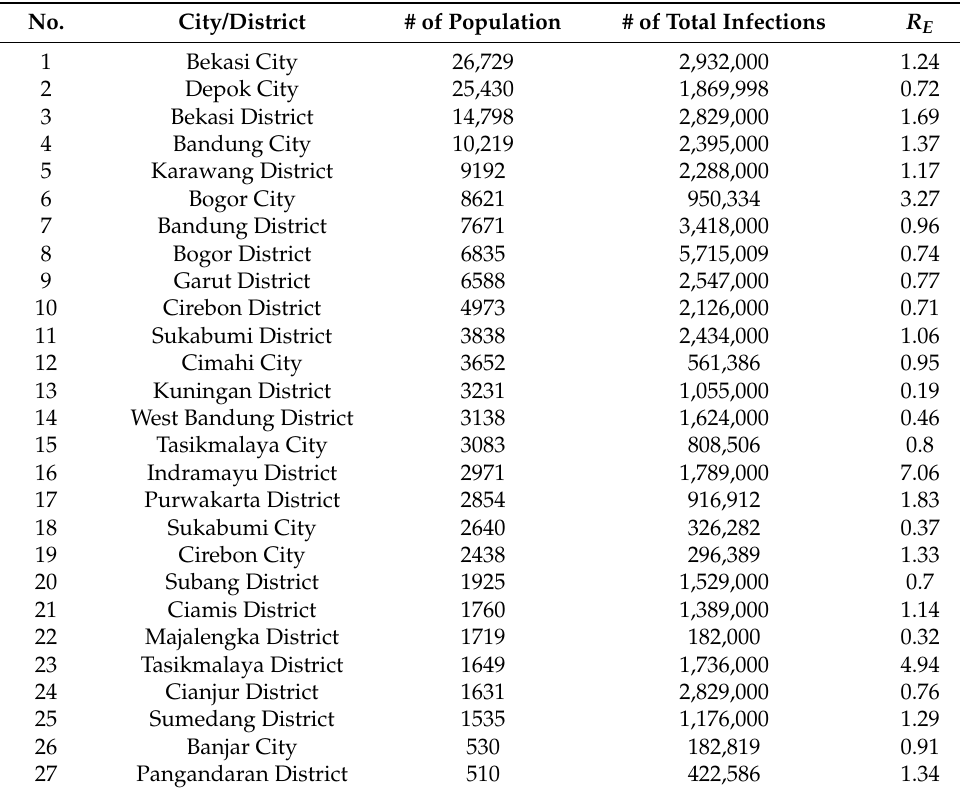
Table A2. Population, COVID-19 Cases and R E in 27 cities/district of West Java.